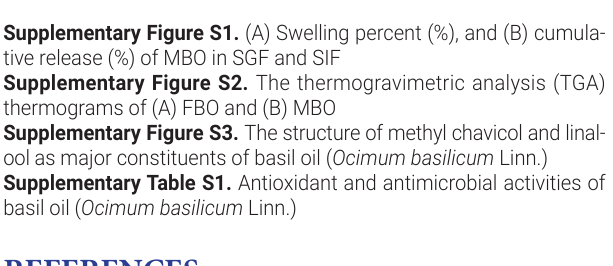
Supplementary Figure S1. (A) Swelling percent (%), and (B) cumula- tive release (%) of MBO in SGF and SIF Supplementary Figure S2. The thermogravimetric analysis (TGA) thermograms of (A) FBO and (B) MBO Supplementary Figure S3. The structure of methyl chavicol and linal- ool as major constituents of basil oil ( Ocimum basilicum Linn.) Supplementary Table S1. Antioxidant and antimicrobial activities of basil oil ( Ocimum basilicum